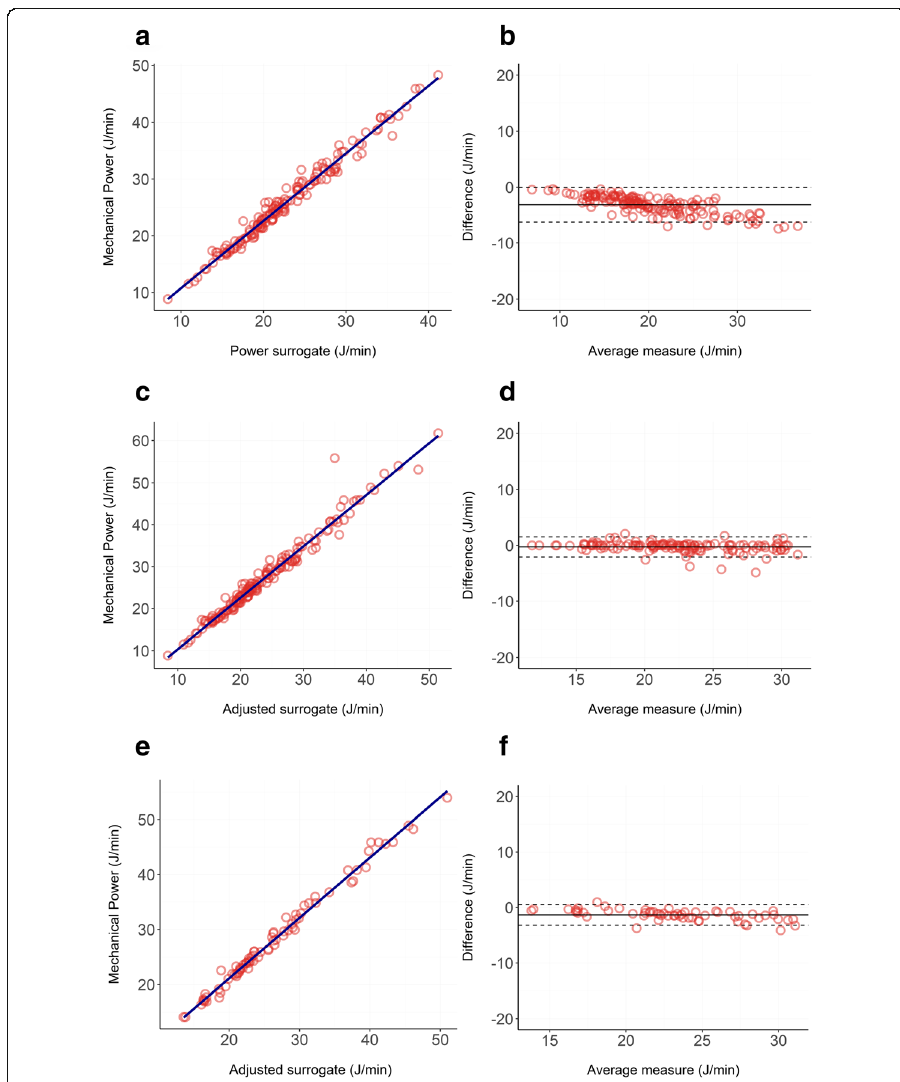
Fig. 5 a , b Relationship between our unadjusted surrogate of mechanical power (Eq. 3) and the reference formula (Eq. 1) in ICU patients treated with 15 cmH 2 O of PEEP: panel a shows the linear regression ( R 2 = 0.97), and panel b shows the Bland-Altman (bias = − 3.14 J/min; proportional error = − 0.21 J/min). c , d Relationship between our adjusted surrogate of mechanical power (Eq. 9) and the reference formula (Eq. 1) in ICU patients treated with 15 cmH 2 O of PEEP: panel c shows the linear regression ( R 2 = 0.97), and panel d shows the Bland-Altman (bias = − 0.28 J/min; proportional error = − 0.05 J/min). e , f Relationship between our adjusted surrogate of mechanical power (Eq. 3) and the reference formula (Eq. 1) in ICU patients treated with 15 cmH 2 O of PEEP and with respiratory system resistances higher than 15 cmH 2 O ∙ sec/liters: panel e shows the linear regression ( R 2 = 0.98), and panel b shows the Bland-Altman (bias = − 1.35 J/min; proportional error = − 0.12